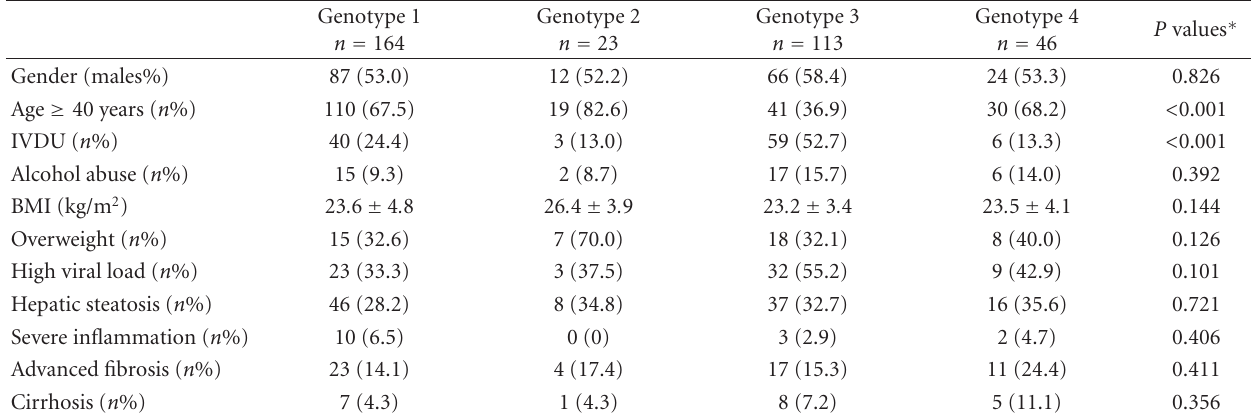
Table 1: Demographic, virological, and histological data according to genotype.